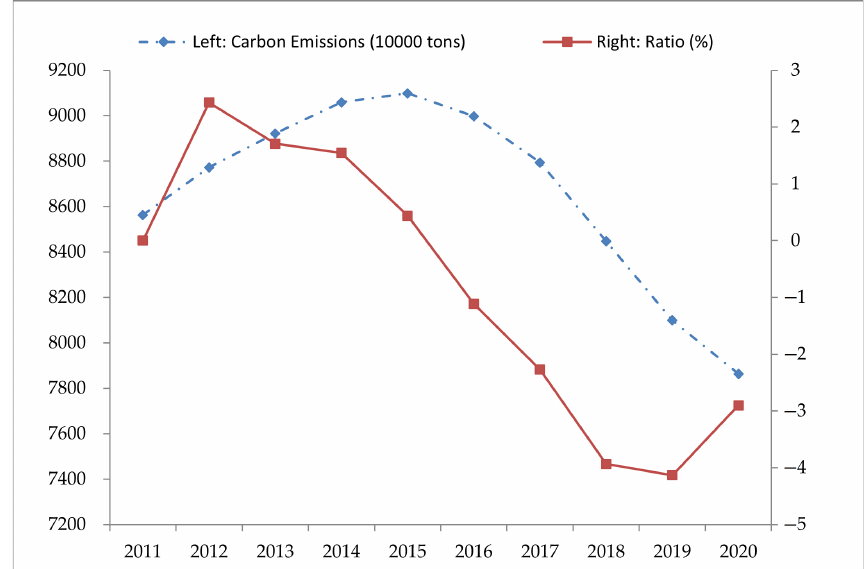
Figure 1. Agricultural carbon emissions and the growth rate.